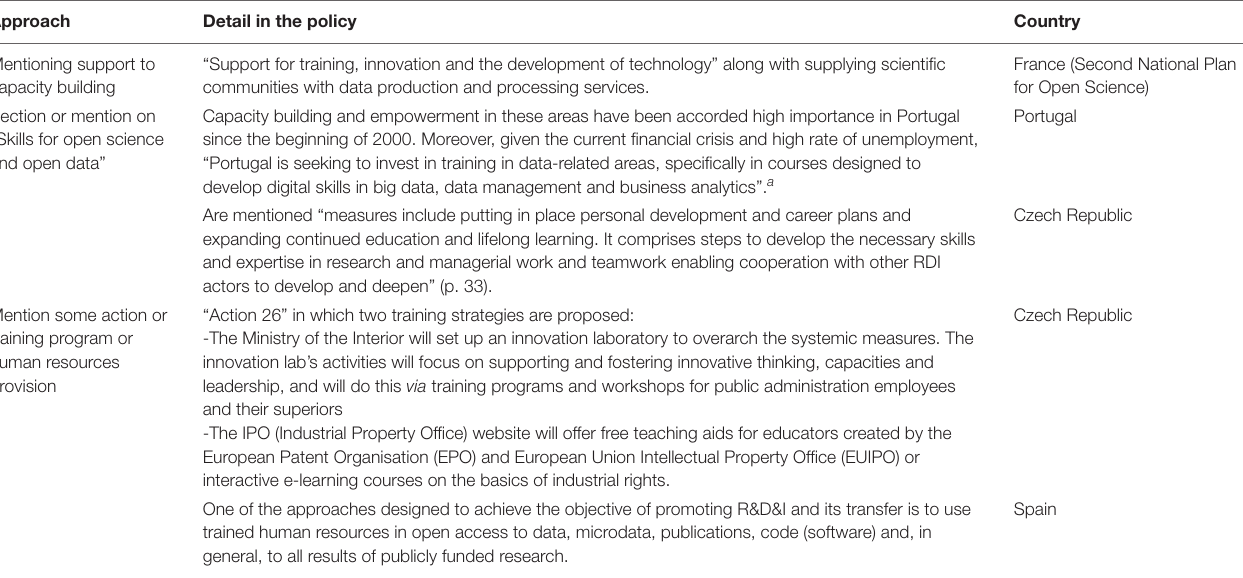
TABLE 3 | Capacity building in national policies or